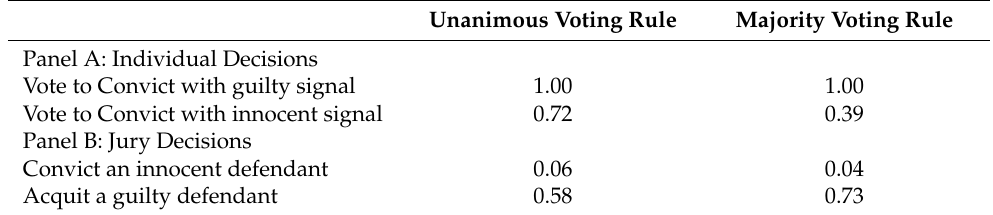
Table 1. Equilibrium predictions (under risk neutrality) on vote proportion for the experimental setup. Unanimous Voting